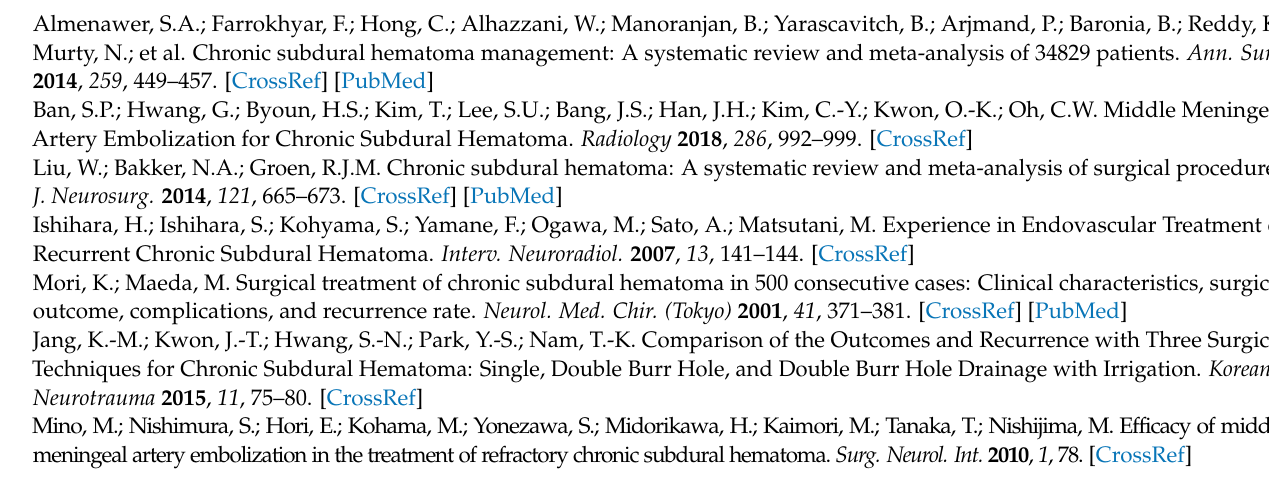
(Historical Controls); Table S3: Patient Demographics and Clinical Characteristics; Table S4: Wilcoxon Score Index based Recurrence